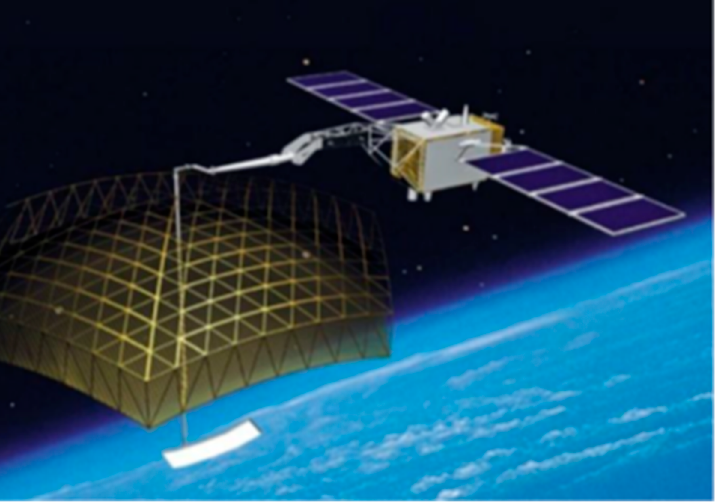
Figure 6. Image of the small spacecraft “Condor-E” with the installed radar [54].